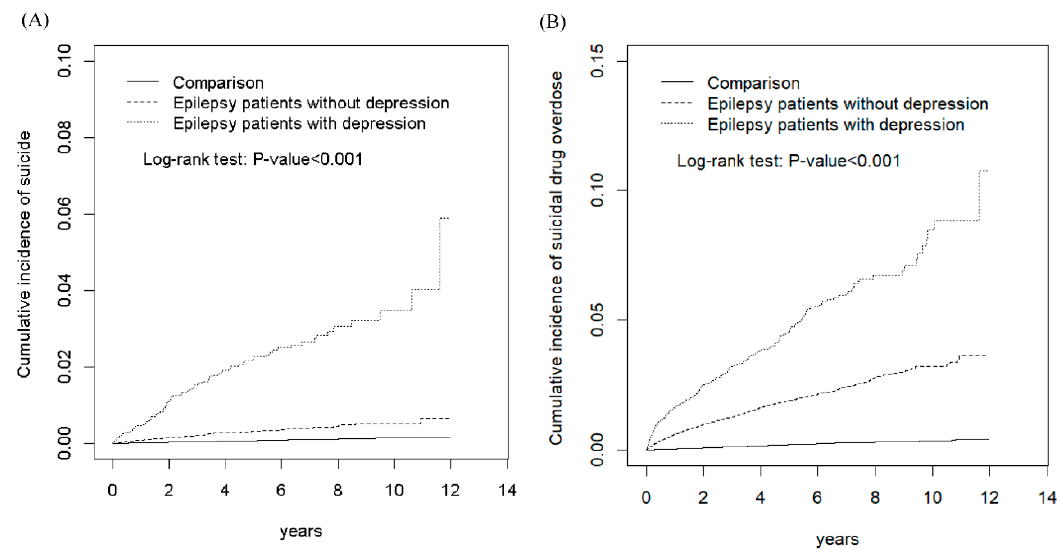
Figure 1. Comparison of cumulative incidence of suicide attempt ( A ) and suicidal drug overdose ( B ) among patients with epilepsy with comorbid depression, patients with epilepsy without comorbid depression, and comparison individuals from the non-affeced population. Table 2. Association of incidence and risk of SA with various risk factors.